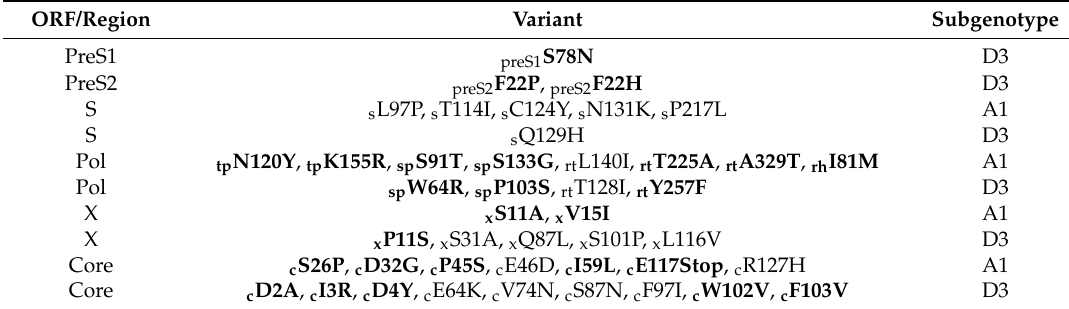
Table 4. OBI unique mutations in the different ORFs.